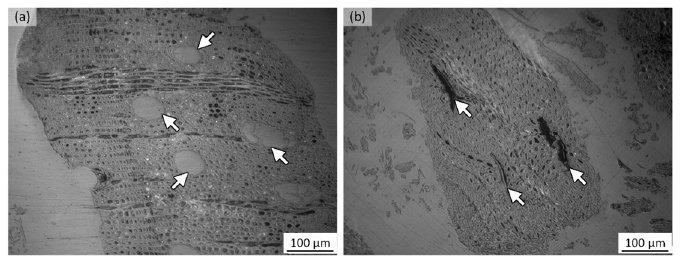
Figure 2. Optical microstructures of ( a ) HW and ( b ) HW:M with white arrows pointing to vessels.